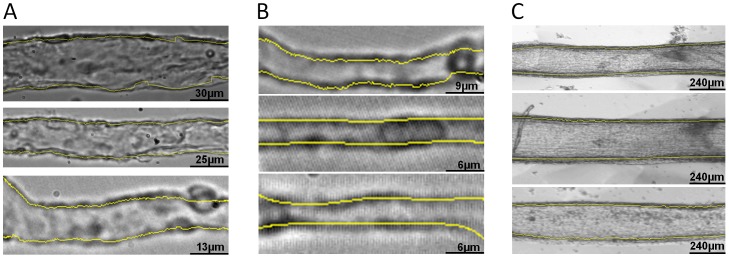
Different vessels tested with MyoTracker.Venules (A) and capillaries (B) from rat retina, and bigger arteries (C) from bovine retinal tissues used to test the algorithm. The lines detected by MyoTracker are shown superimposed in yellow on top of the vessels. Spline interpolation was used to improve the detection of the walls in all vessels in section A. The detection of 2 of the capillaries also required the assistance of some additional parameters from the program (see the manual of the software, File S1). To detect the walls in the middle and bottom panels in section B, preprocessing was checked. The other parameters were as follows: Level = 1, Preferred smoothing spacing = 25, Pixel tolerance = 100, Derivative = 2, Light correction = 6 (with the flags light correction and Use spline interpolation checked). The detection of the walls in the arteries was carried out with Preferred smoothing spacing = 100 (the other parameters had default values).